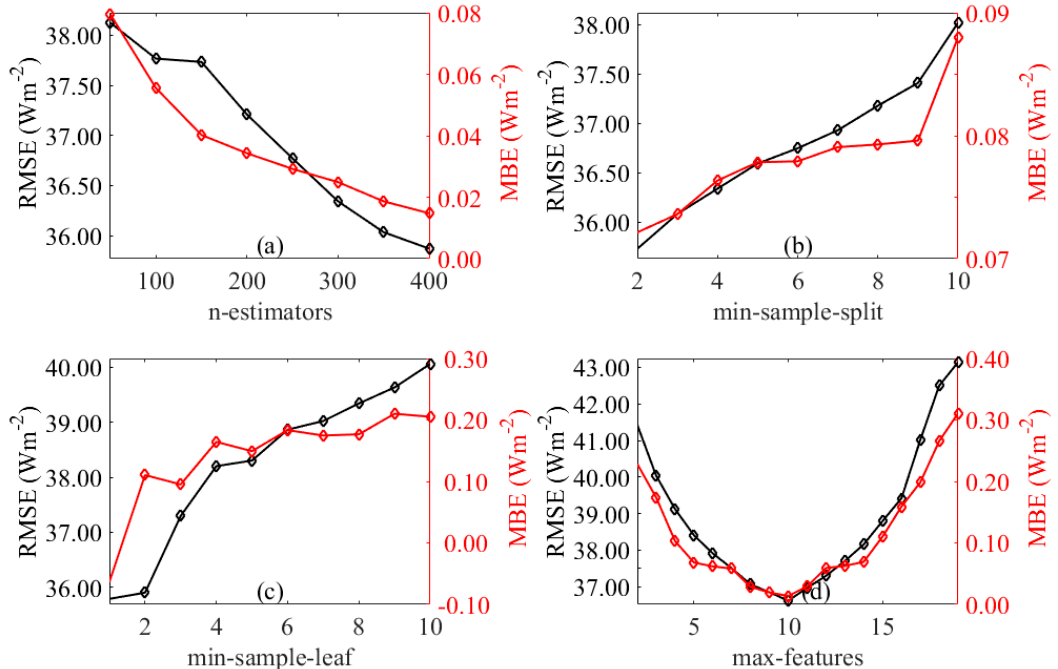
Figure 4. Sensitivity analysis of RMSE and MBE values to the ( a ) n-estimators; ( b ) min-sample-split; ( c ) min-sample-leaf; ( d ) max-features of the RF method.